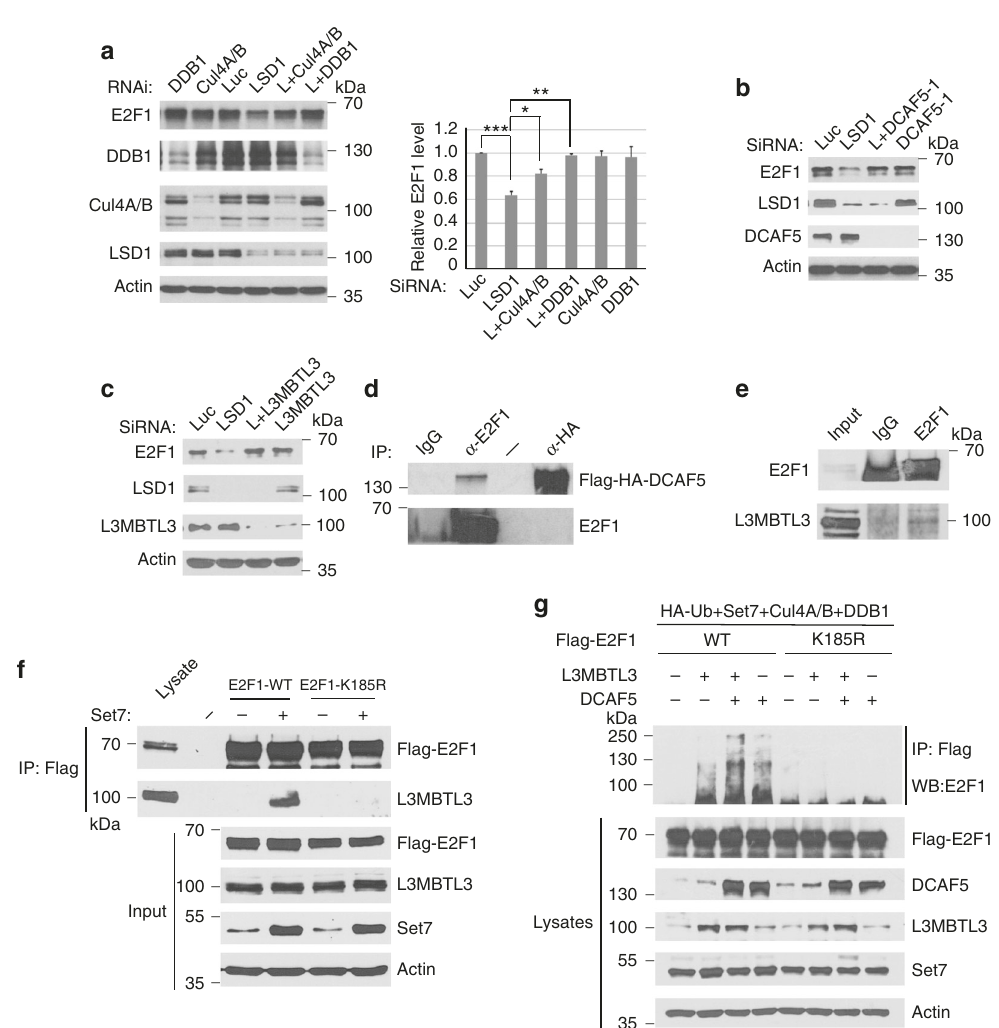
Fig. 9 L3MBTL3 and CRL4 DCAF5 regulate the methylation-dependent proteolysis of E2F1. a Downregulation of the CRL4 core complexes stabilized E2F1 in LSD1 knockdown cells. HCT116 cells were transfected with 50 nM siRNAs for each CRL4 core component, with or without LSD1 siRNA (LSD1 or L). E2F1 and indicated proteins were detected as indicated. Quanti fi cations were represented by bar graph with mean and S.D. for error bars from three independent replicates, and Student ’ s t-test was calculated for signi fi cant differences, as described in Fig. 2a. * P < 0.05, ** P < 0.01 and *** P < 0.001. b Downregulation of DCAF5 stabilizes E2F1. HCT116 cells were transfected with DCAF5 siRNA with or without LSD1 siRNA as indicated. E2F1, DCAF5, LSD1 and actin were examined by Western blotting, as in a . c Downregulation of L3MBTL3 prevents E2F1 proteolysis in LSD1 knockdown cells. HCT116 cells were transfected with control and L3MBTL3 siRNAs with or without LSD1 siRNA. E2F1, L3MBTL3, LSD1 and actin were examined by western blotting. d Ectopically expressed DCAF5 interacts with E2F1. Lysates from HCT116 cells expressing a stably expressed Flag-HA-DCAF5 were immunoprecipitated and blotted with indicated anti-HA and E2F1 antibodies. e L3MBTL3 and E2F1 interact with each other. Endogenous L3MBTL3 and E2F1 proteins were immunoprecipitated from HCT116 cells and western blotted with anti-E2F1 and L3MBTL3 antibodies as indicated. f The interaction between L3MBTL3 and E2F1 is dependent on the presence of K185 in E2F1. The Flag-wild-type E2F1 and Flag-K185R mutant expression constructs were transfected into HCT116 cells with or without SET7 expression as indicated. The interactions between L3MBTL3 and Flag-E2F1 or its K185R mutant were analyzed by anti-Flag and anti-L3MBTL3 immunoprecipitation and western blotting. Input: total cell lysates. g L3MBTL3 and CRL4 DCAF5 ubiquitin E3 ligase complexes target E2F1 for polyubiquitination. Flag-E2F1 or Flag-K185R mutant expressing constructs were co-transfected into 293 cells together with vectors expressing HA-tagged ubiquitin (HA-Ub), SET7, CUL4A, CUL4B, and DDB1, in the presence or absence of L3MBTL3 and DCAF5 expressing constructs as indicated. The transfected proteins were immunoprecipitated with anti-Flag antibodies and Western blotted with anti-E2F1 antibodies. Experiments were repeated three independent times with the same